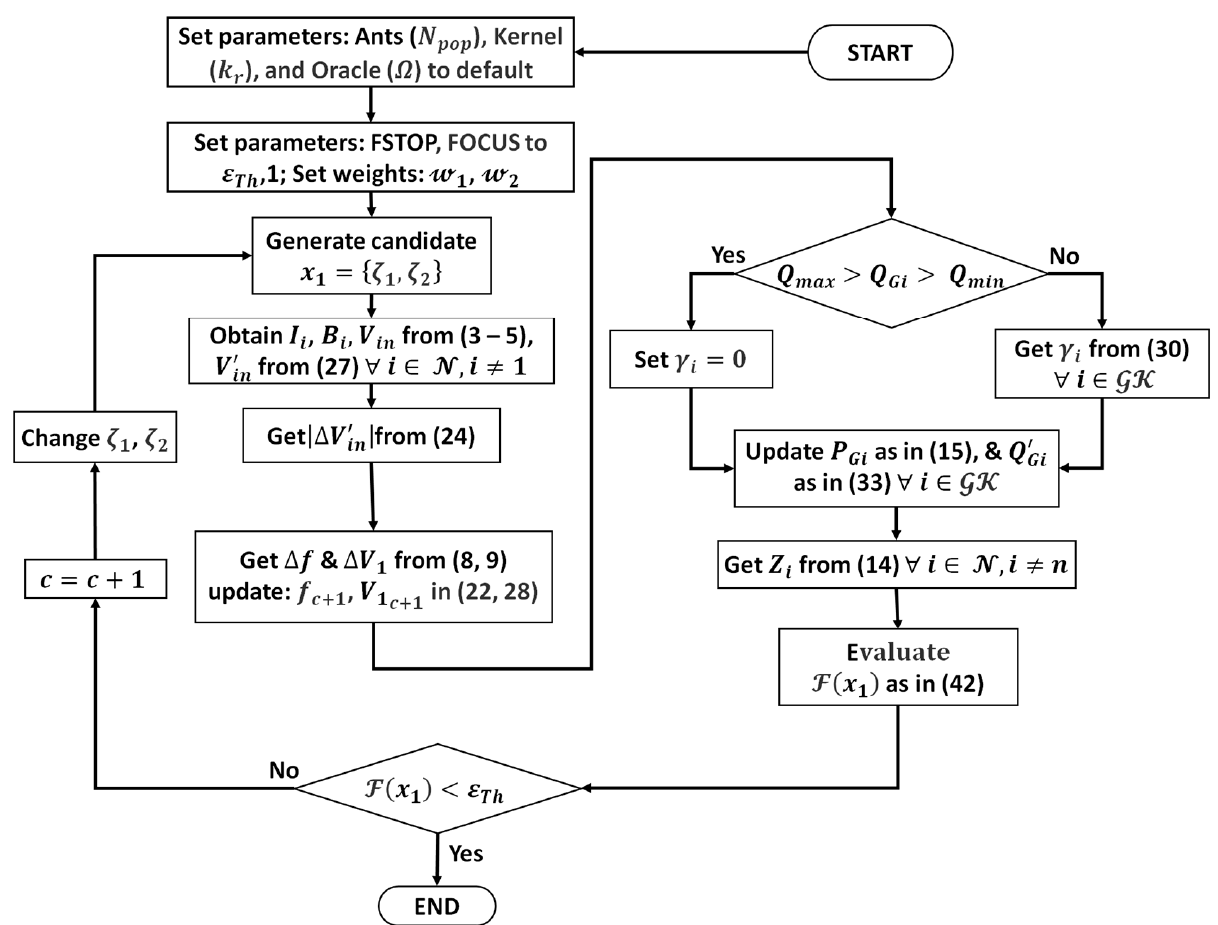
Figure 5. General backward/forward sweep load flow method.